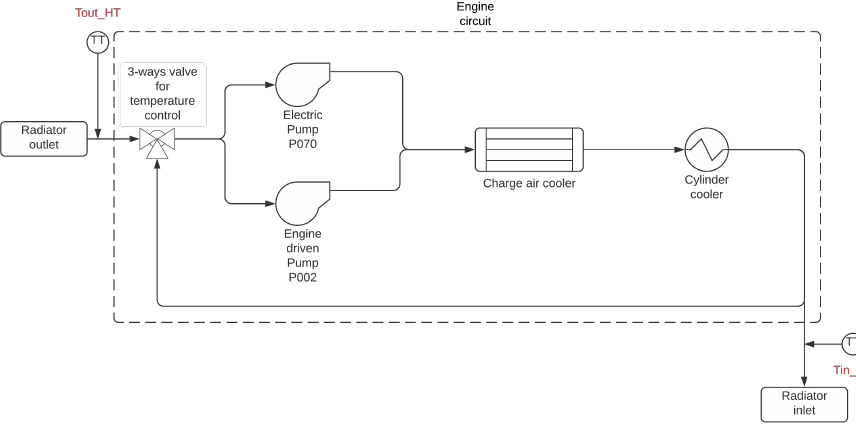
Figure 2. Temperature control system for cooling of an engine.